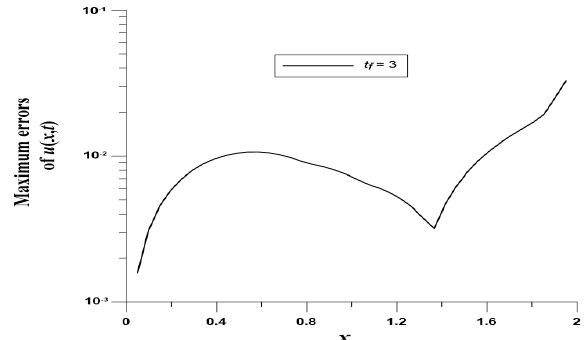
Figure 10. For Example 5 of the backward nonlocal wave problem: ME( u ) versus x with different final times.